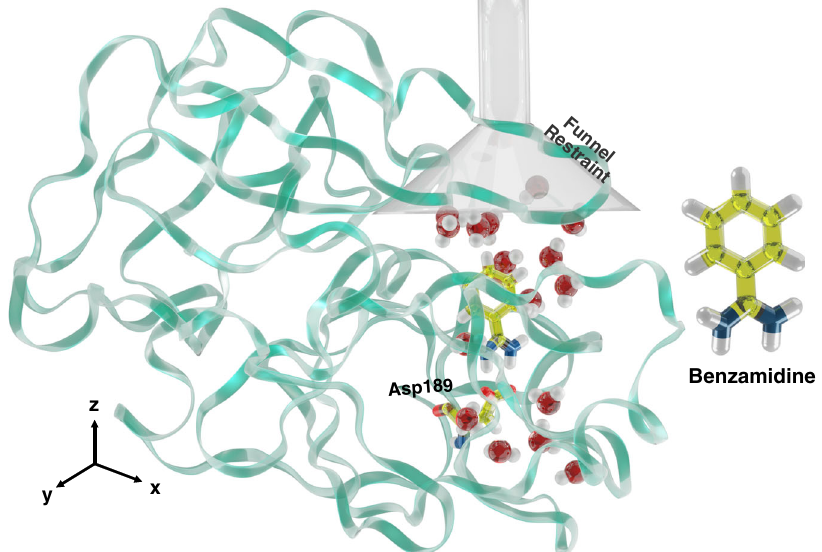
Fig. 1 | The Trypsin-Benzamidine system. A cartoon representation of Trypsin structurewith the ligand Benzamidine and the Funnel restraint geometry. Oxygen, Nitrogen, Hydrogen, and Carbonatoms arecolored in red,blue, white, and yellow,